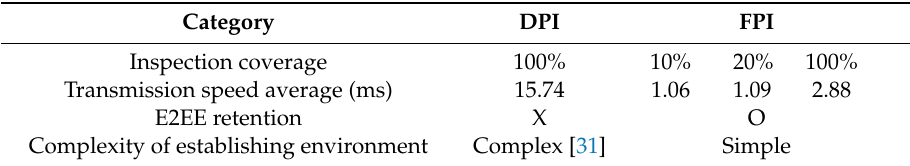
Table 1. Comparison of DPI and